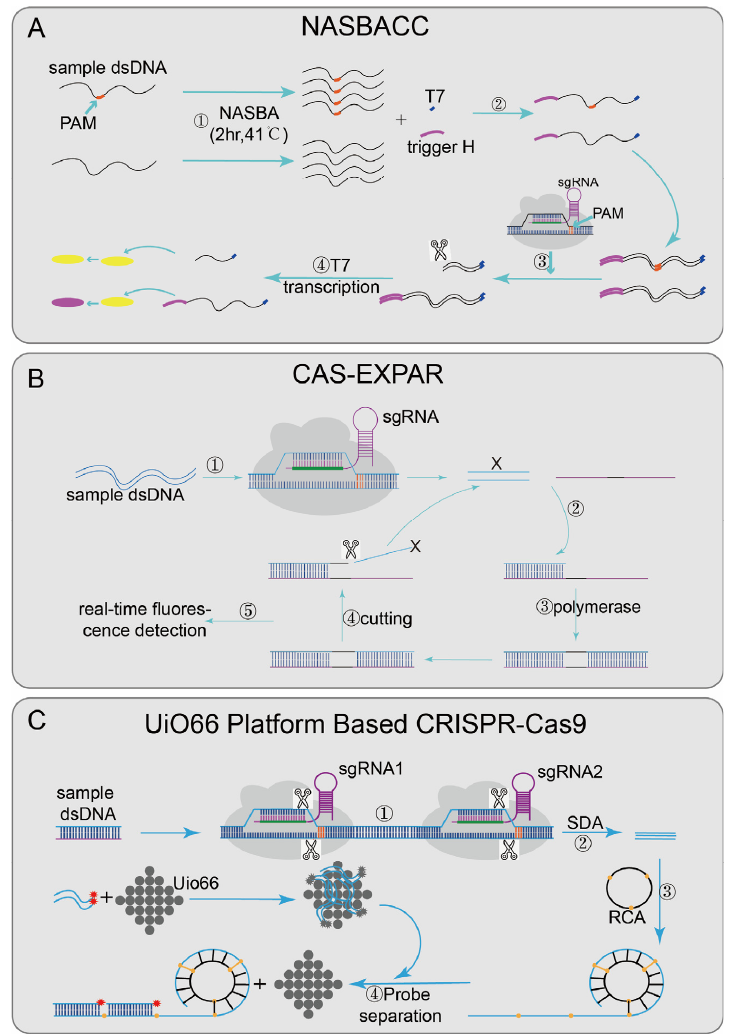
Figure 2. Applications of CRISPR/Cas9 technology: ( A ) NASBACC designed a sgRNA based on